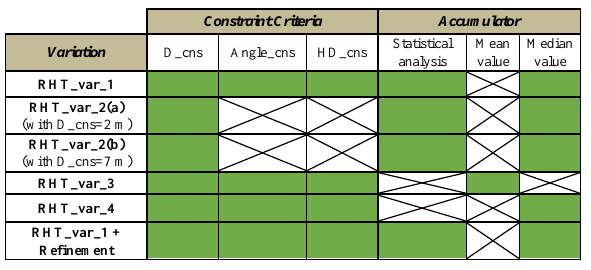
Table 1. The applied variations of the